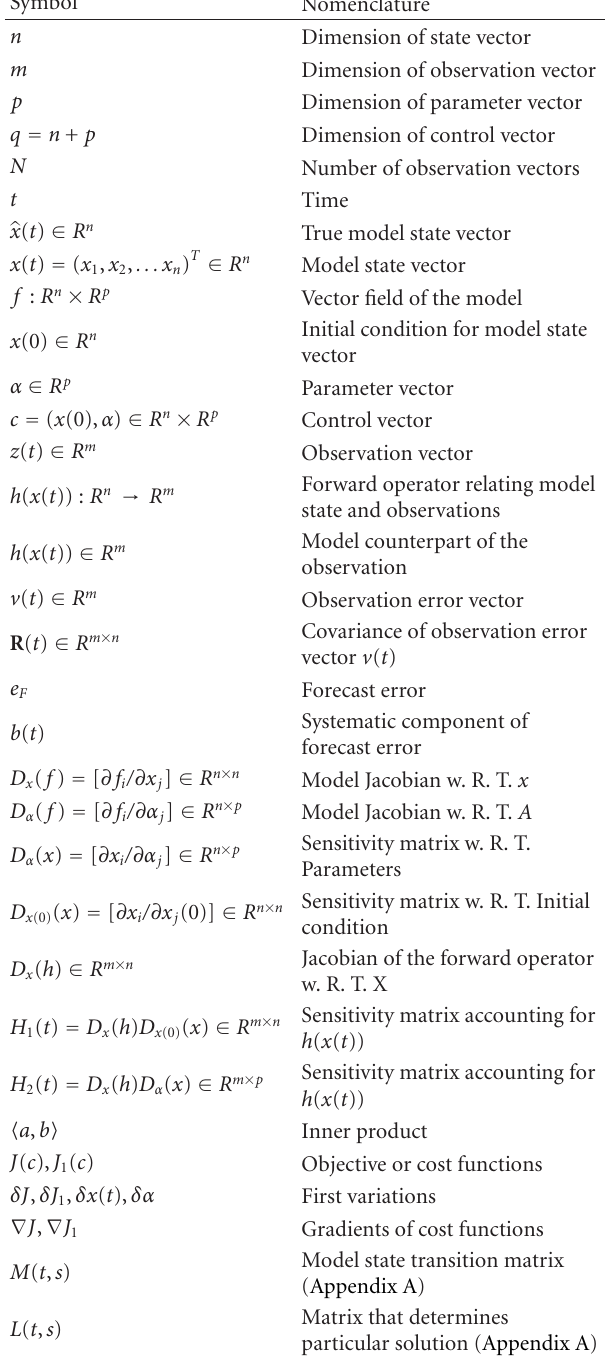
Table 1: Symbolism and